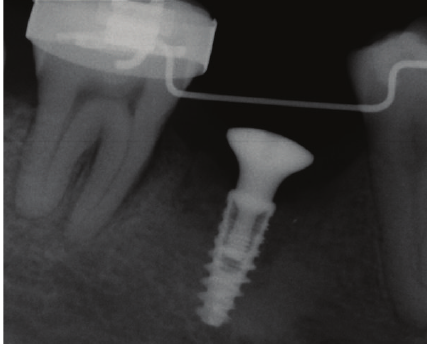
Figure 16: Radiographic control of the healing abutment adjustment.